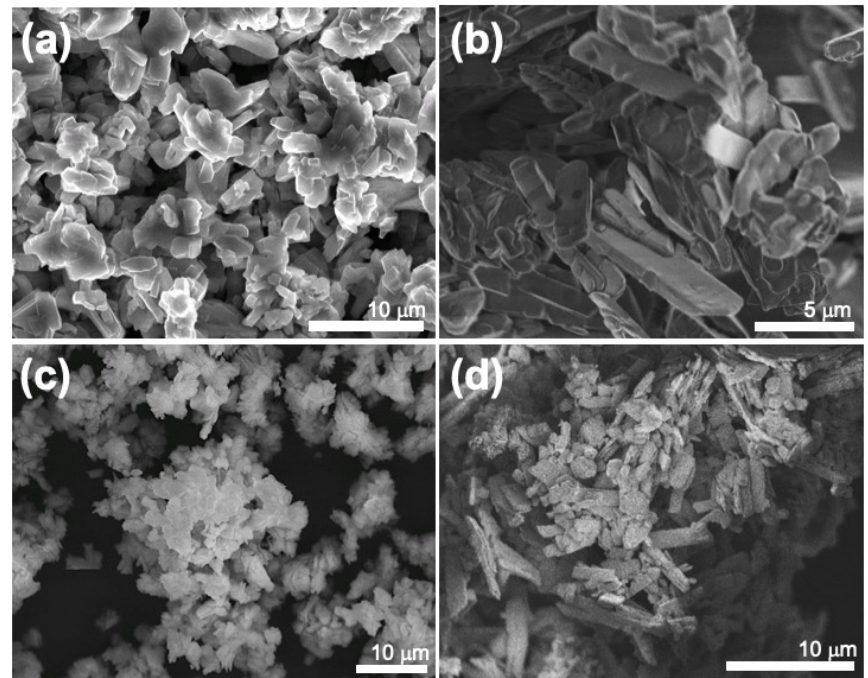
Figure 10. SEM micrographs of ( a , b ) lanthanum oxalates and ( c,d ) lanthanum oxides samples.